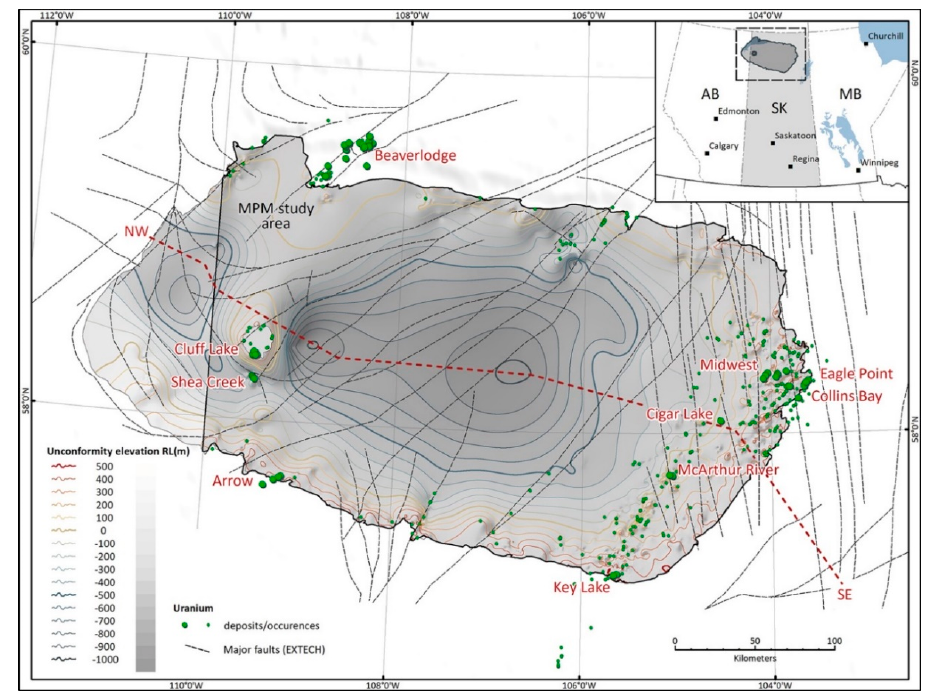
Figure 3. Unconformity elevation contours—Athabasca Basin. Contours indicate the elevation of the unconformity at the base of the late Paleoproterozoic to Mesoproterozoic Athabasca Group. The unconformity isosurface was interpolated from historical drill-hole data. The Athabasca Basin MPM study area is indicated by the dark black outline. The red dashed line (NW-SE) marks the trace of the cross section shown in Figure 4b.